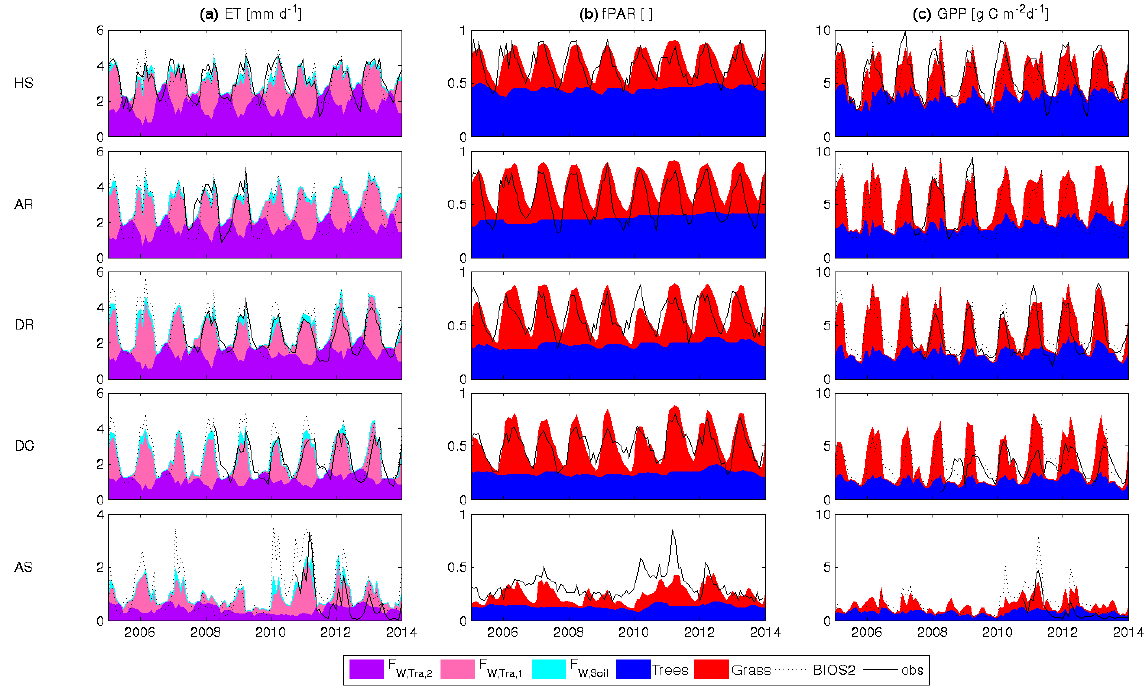
Figure 3. Monthly (2005–2013) time series of (a) ET, (b) fPAR, and (c) GPP at five flux stations: HAVANA-POP (stacked plots), BIOS2 (full biogeochemical model with prescribed vegetation cover), and observations. HAVANA-POP ET is partitioned into soil evaporation and transpiration from each of the upper (1) and lower (2) soil layers. HAVANA-POP fPAR and GPP are partitioned into tree and grass components. Flux site abbreviations (left of figure) are given in Table